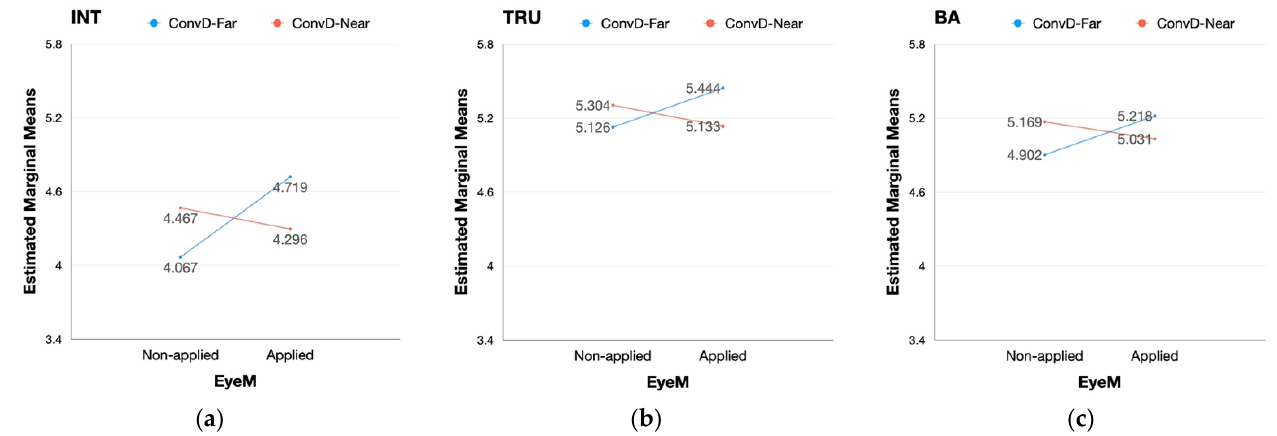
Figure 5. Pick-up service scenario: interaction effect between eye movement (EyeM) and conversa- tional distance (ConvD); ( a ) interaction effect on intimacy; ( b ) interaction effect on trust; ( c ) interaction effect on brand attitude.